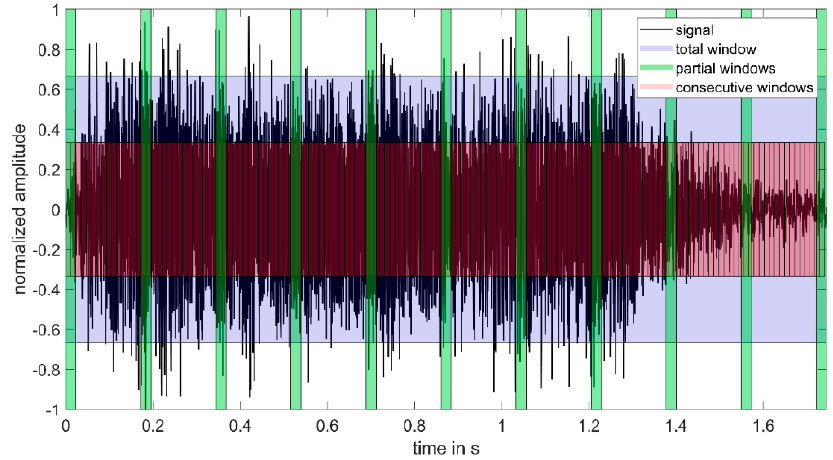
Figure 2. Illustration of different types of windows. “Total” refers to a single window including the entire signal, “partial” refers to single windows only containing small subsections of the signal, and “consecutive” refers to multiple consecutive, overlapping windows.